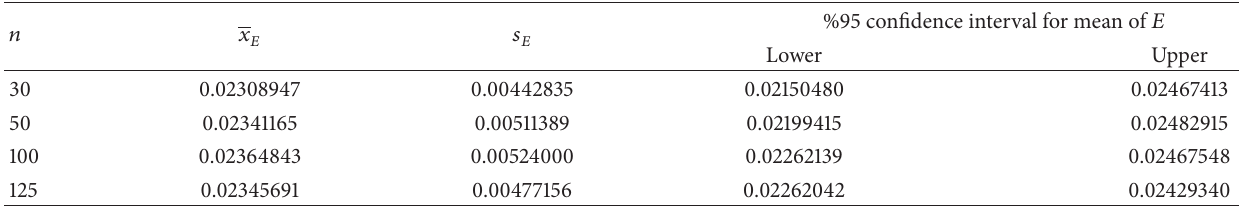
Table 3: Mean, standard deviation, and confidence interval for error mean in Example 1 with 𝑚 = 32